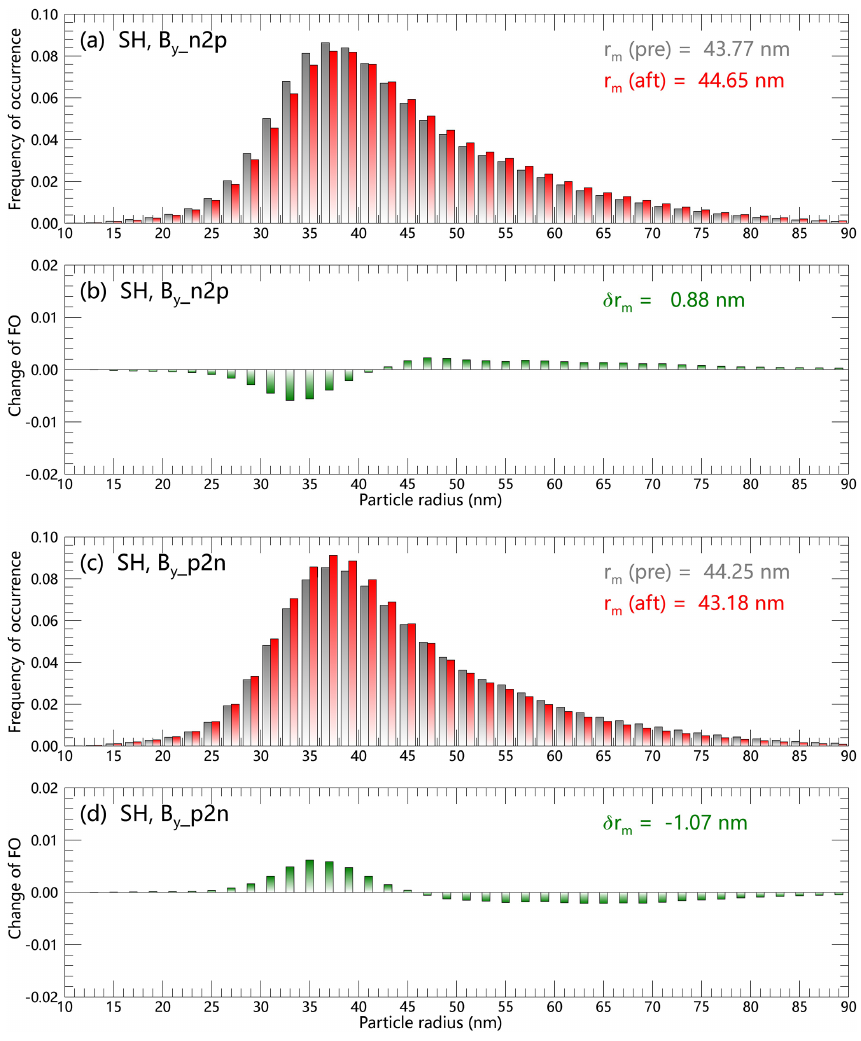
Figure 7. Changes in ice particle radius distribution δf ( r ) during n2p and p2n IMF B y reversals in the Southern Hemisphere. The distribu- tions of r over all pixels 3d before (after) the key days are indicated by the gray (red) bars, and the changes between them are shown by the green